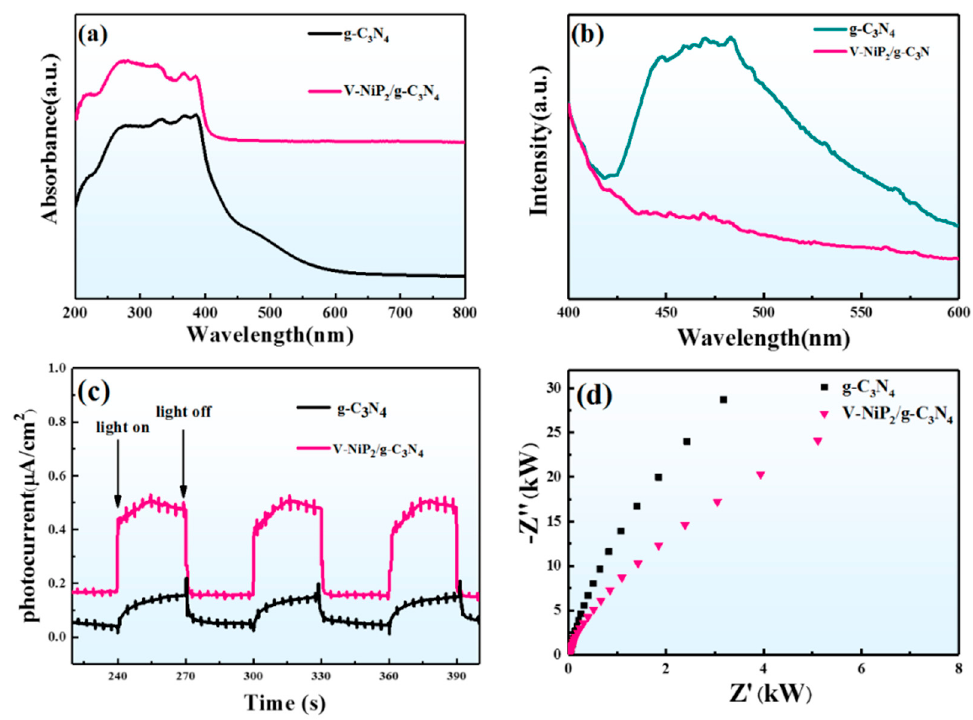
Figure 4. ( a ) UV–vis diffuse reflection spectra of pure g-C 3 N 4 and V-NiP 2 /g-C 3 N 4 ; ( b ) The photoluminescence (PL) spectra of g-C 3 N 4 and V-NiP 2 /g-C 3 N 4 ; ( c ) Transient photocurrent responses of g-C 3 N 4 V-NiP 2 /g-C 3 N 4 ; ( d ) EIS Nyquist plots of g-C 3 N 4 and V-NiP 2 /g-C 3 N 4 in 0.5M Na 2 SO 4 solution visible light irradiation.